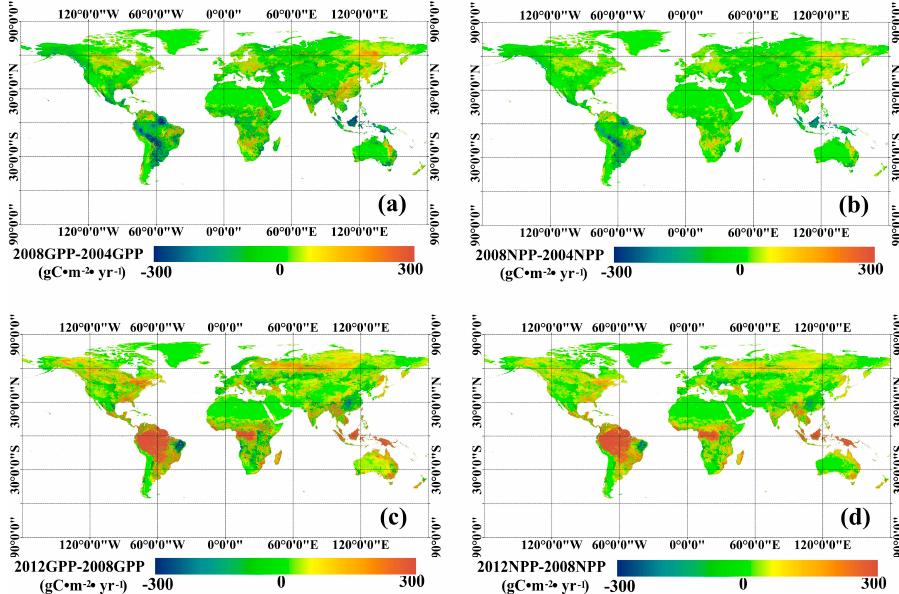
Figure 4. Variations in global GPP and NPP from 2004 to 2012: ( a ) variation in GPP from 2004 to 2008; ( b ) variation in NPP from 2004 to 2008; ( c ) variation in GPP from 2008 to 2012; ( d ) variation in NPP from 2008 to 2012.